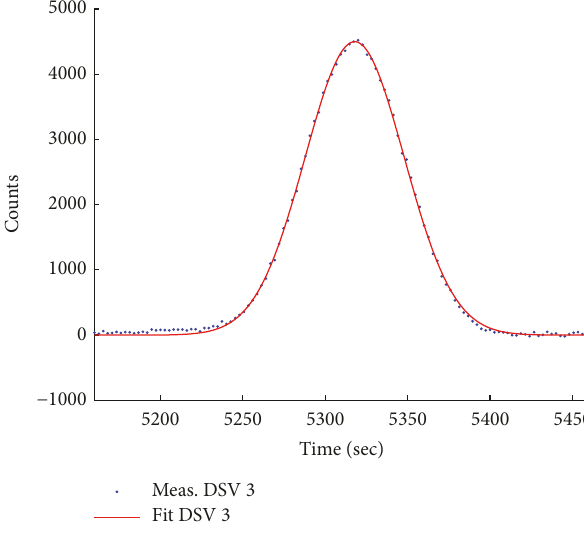
Figure 2: Moon intrusion event in different deep space views on 15 November 2010, with channel H1 of MHS on NOAA-18; blue: DSV 1; black: DSV 2; red: DSV 3; green: DSV 4. Top: angle between Moon and space view as calculated with AAPP. Bottom: space view counts. The time is given in seconds after 17:23 UT, the time of the first scan in the raw data file (level 1b). The angles calculated with AAPP are notquiteaccurate,and this is why DSV 2gives a slightly larger signal than DSV 4 [7].